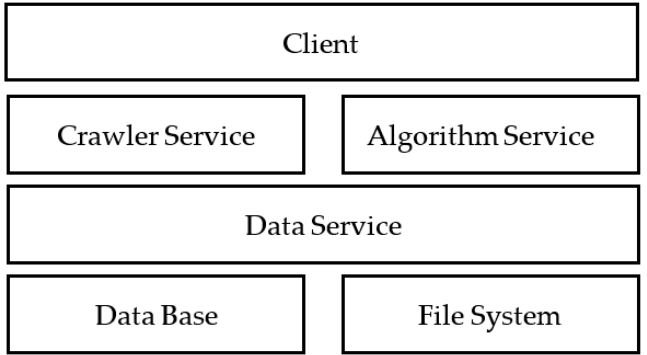
Figure 1. Components of Energy Supply and Demand Forecasting System.